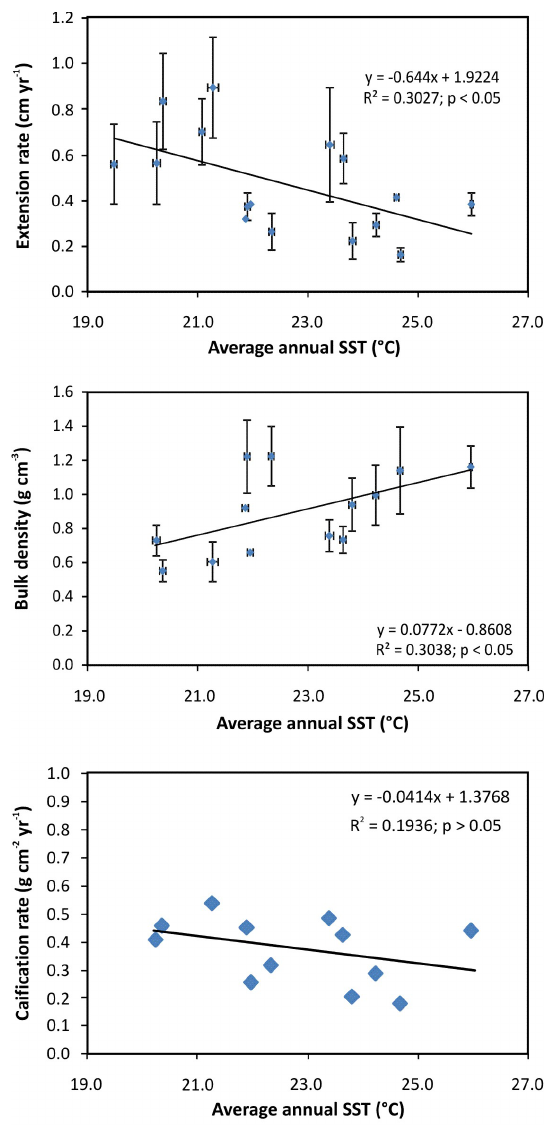
Figure 6. Diagrams showing annual extension rate (cmyr − 1 ) , bulk density (gcm − 3 ) and annual calcification rate (gcm − 2 yr − 1 ) with water temperature inferred from published δ 18 O values (Brachert et al.,